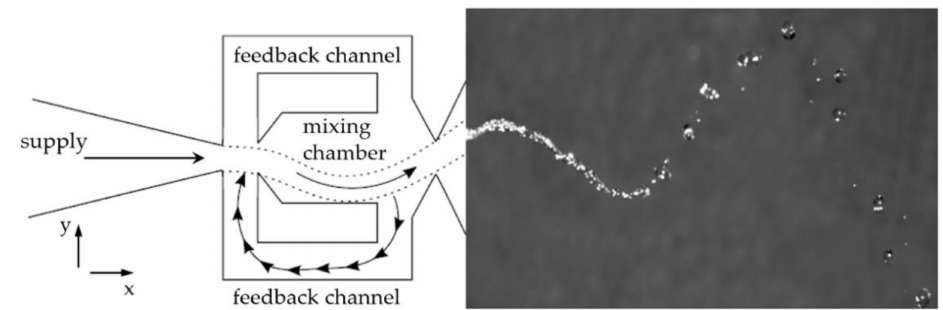
Figure 8. Working principle of a fluidic oscillator according to [34].